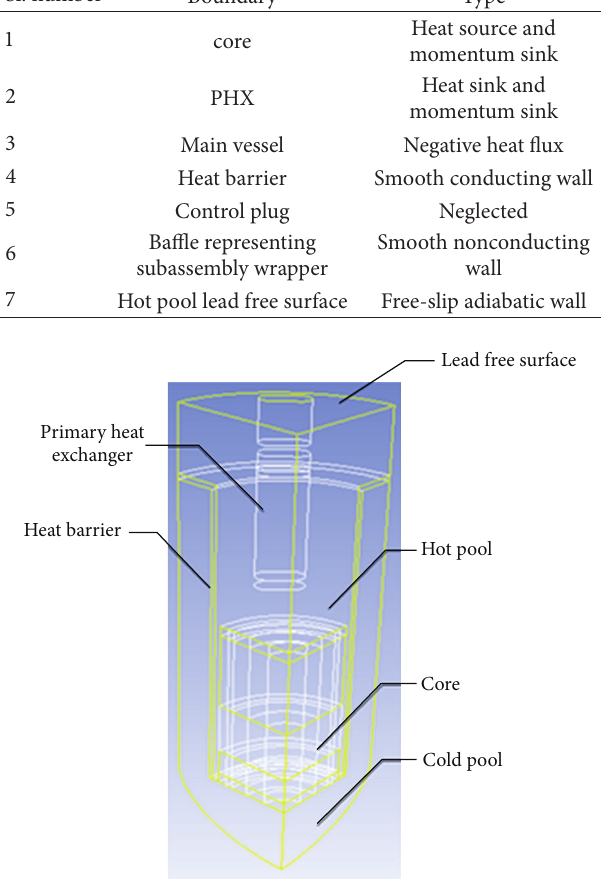
Figure 9: The 3D CFD model of SNRLFR-100 primary cooling